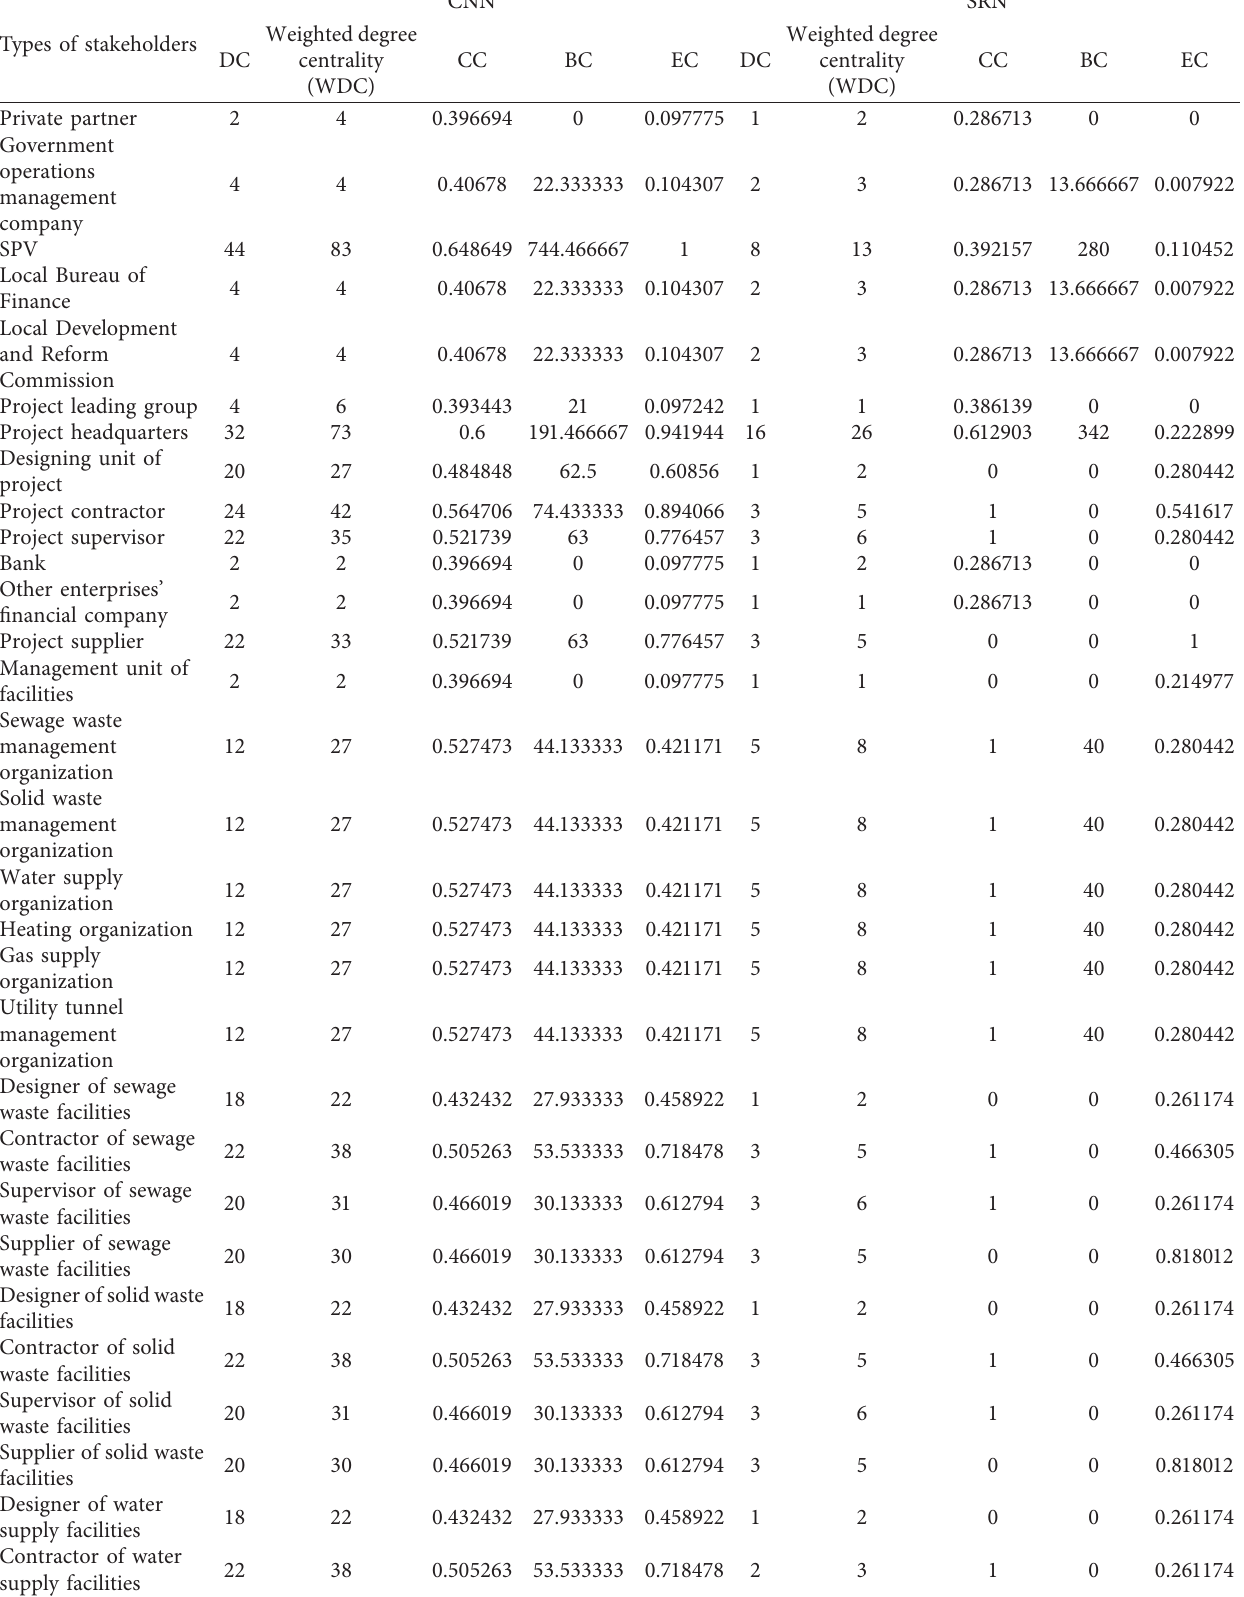
Table 1: CCN and SRN centrality